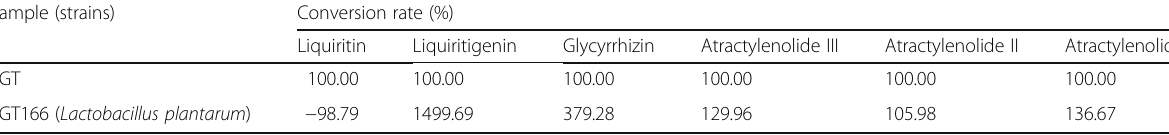
Table 3 Conversion rate of detected six compounds in SGT116 Sample (strains)